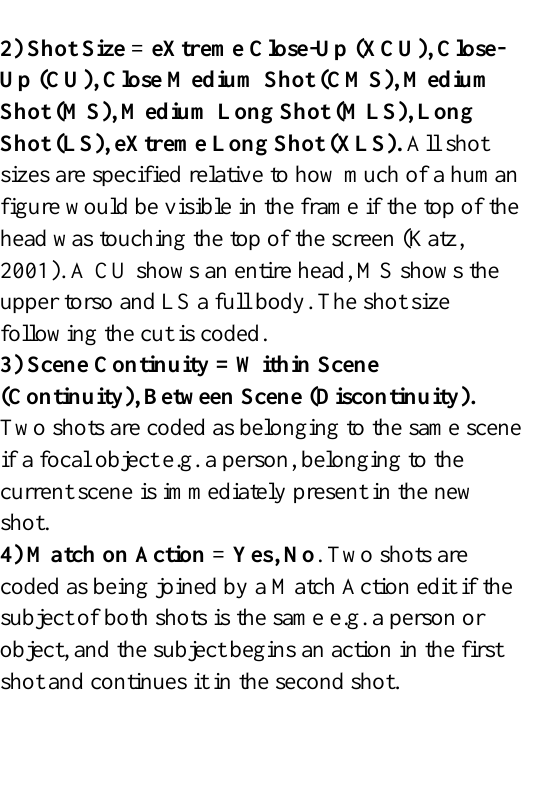
Table 1: General edit statistics for the seven feature film excerpts used in this study: Number of edits in the 5 minute excerpt (Num. Edits), Average Shot Length (ASL; seconds), Percentage of edits that are cuts (Cut; %), Percentage of cuts that were of shot size (Size; %) Close-Up (CU), Close Medium Shot ( CMS), orMedium Shot ( MS), Percentage of cuts of size CU, CMS, or MS that were classified as Between Scene, Within Scene, Match Action, or Gaze Match (%). Averages across all seven films are displayed in the bottom